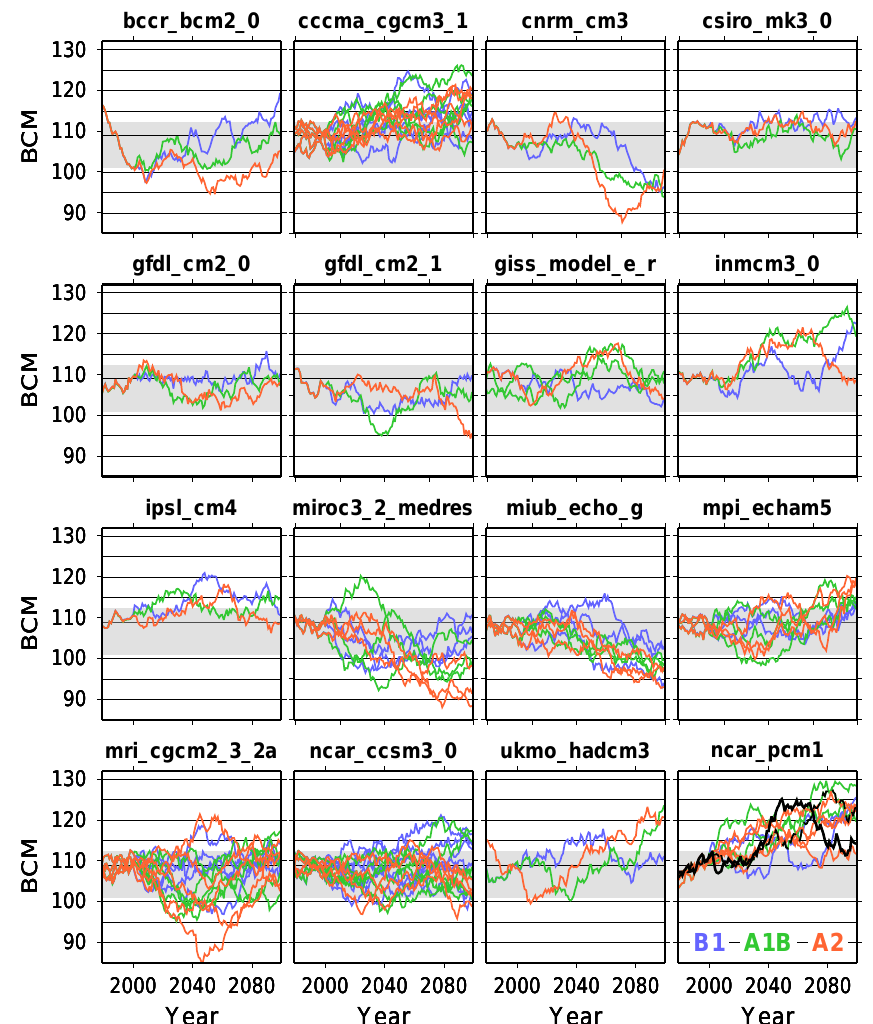
Fig. 9. Time evolution of projected 30-yr average (trailing) of total annual precipitation upstream of Lees Ferry, AZ. Projections are color- coded by emissions pathway (see bottom right panel), with the exception of two runs that are highlighted for the NCAR PCM1 model (see